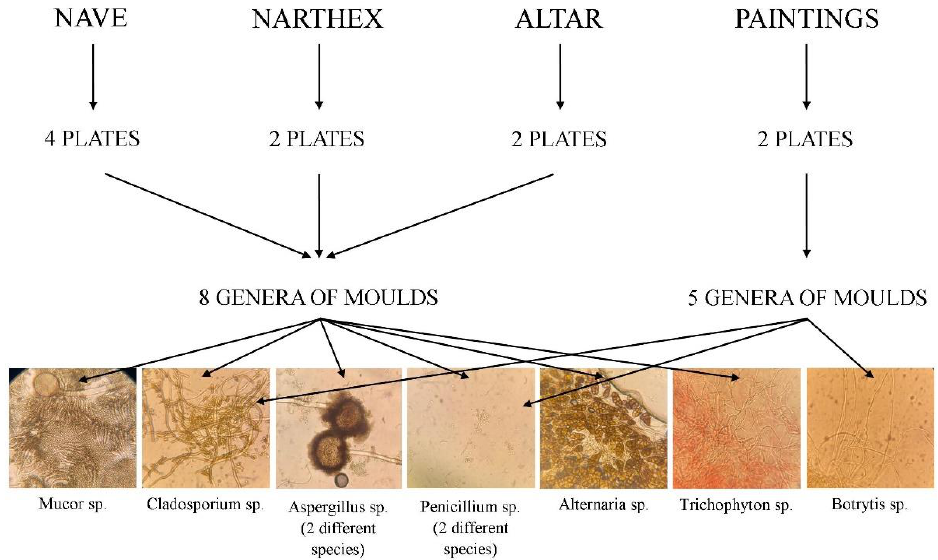
Figure 6. The genera of fungi identified inside the wooden church historical monument.